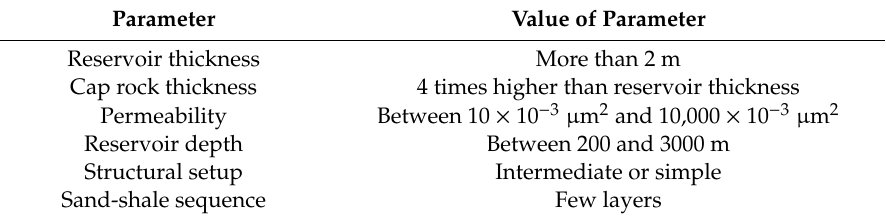
Table 5. The most important parameters and their values for a successful waste injection [72,73].